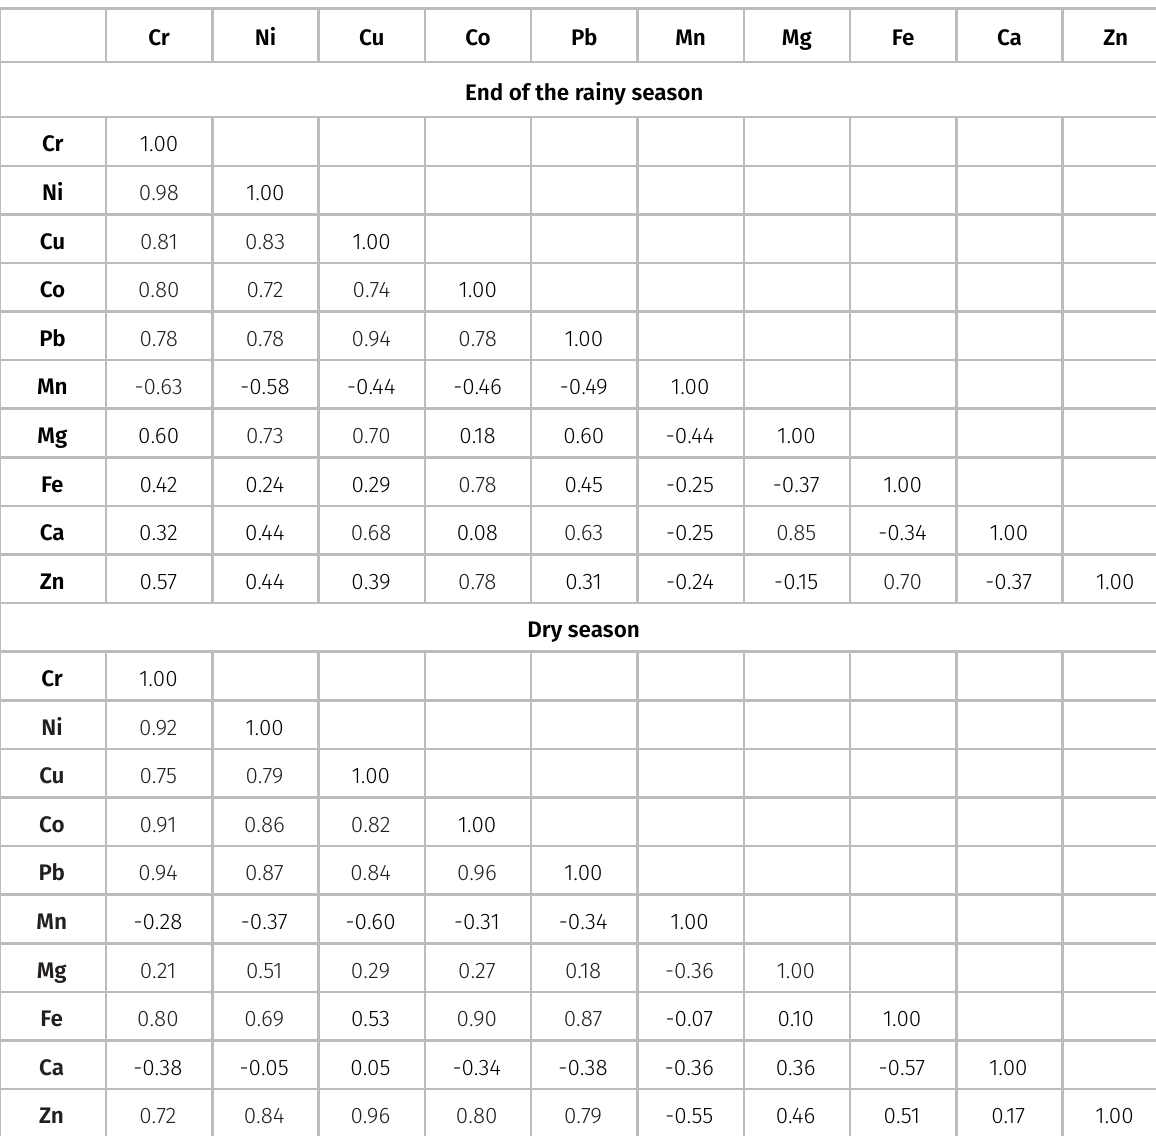
Table V. Correlation matrix of the pseudo-total metal concentrations in sediments of the Jequiezinho River in (a) March 2018 and (b) September 2018 (in bold, significant correlation p <0.05).